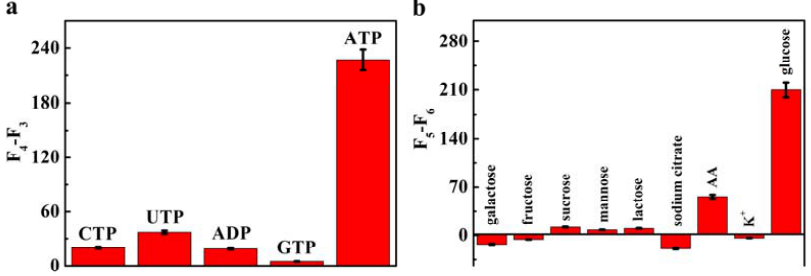
Figure 7. Selectivity of detection of ATP ( a ) and glucose ( b ). The concentrations of ATP and other